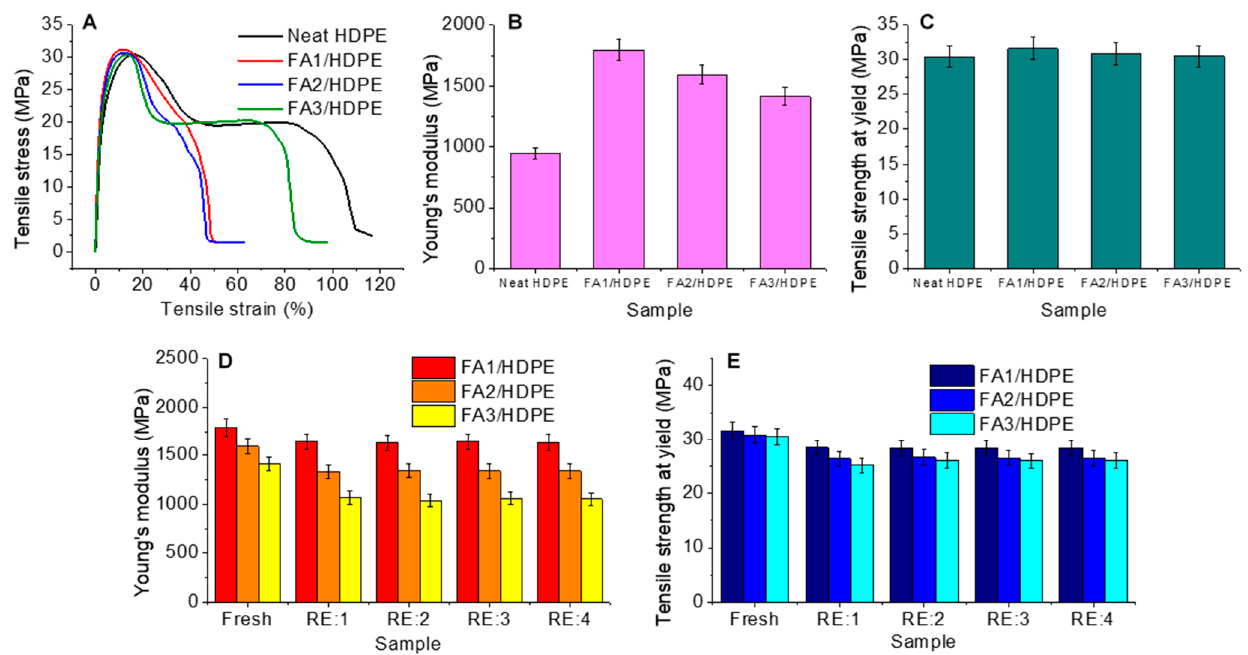
Figure 4. Tensile test results: ( A ) stress-strain curves of freshly made injection moulded samples, ( B ) Young’s modulus of fresh samples, ( C ) tensile strength of fresh samples, ( D ) comparative Young’s moduli of fresh and recycled composites, and ( E ) comparative tensile strength of the fresh and recycled composites. (Error bars show the deviation of tensile results obtained from four different samples).